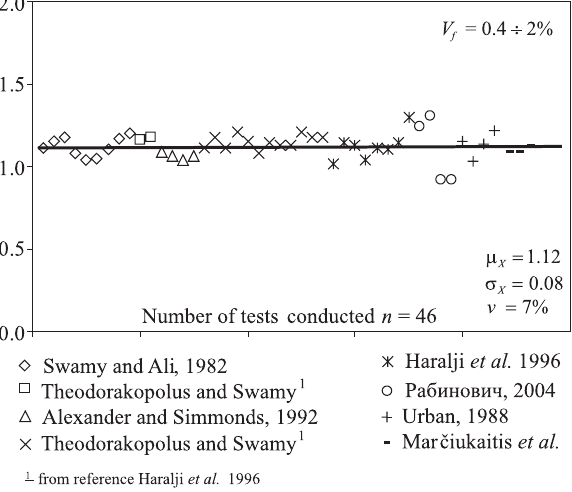
Fig. 10. Accuracy of analytical model with SFRC